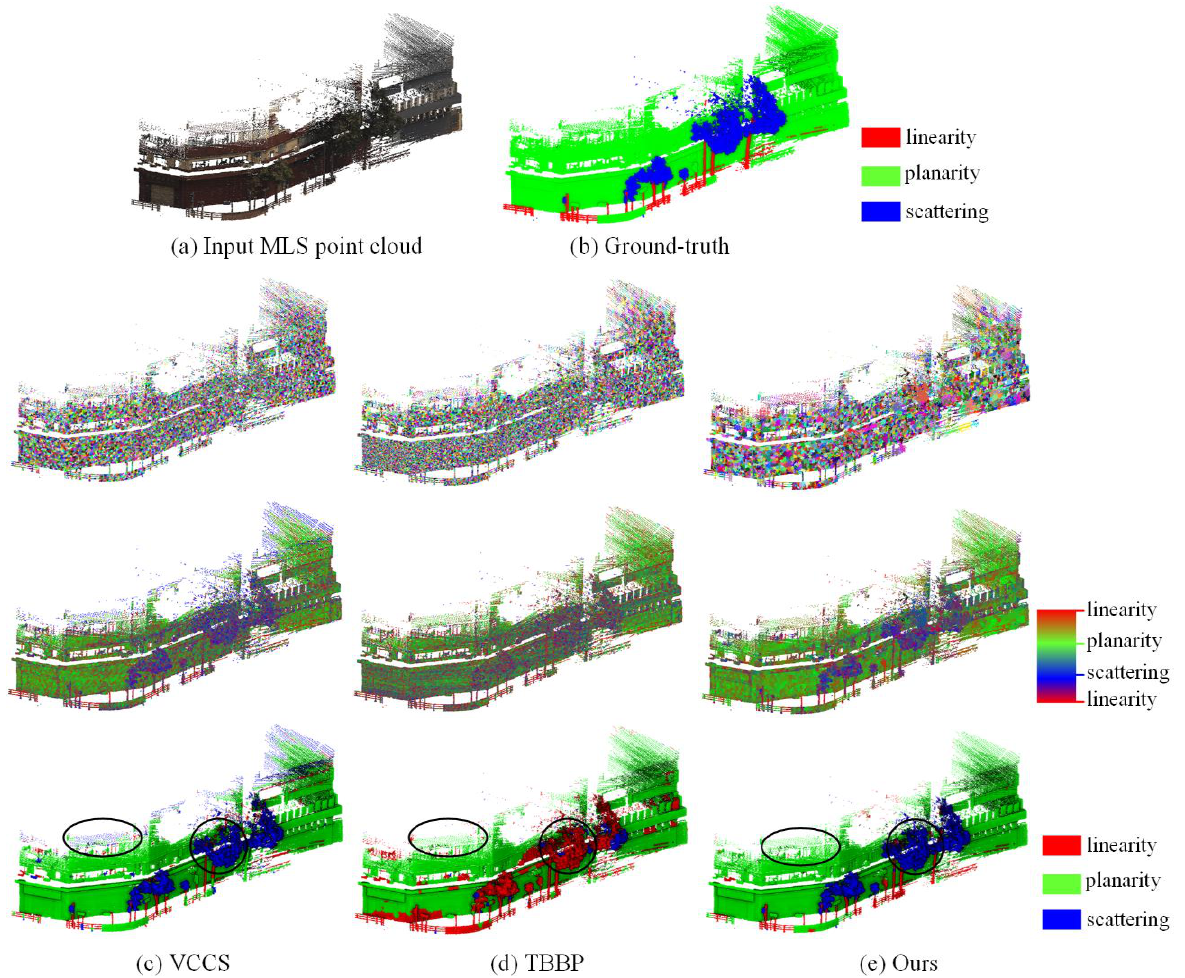
Figure 5. Comparison of structural segmentation results of the MLS dataset. (a) is the input MLS point cloud, (b) is the manually labeled ground-truth with red, green and blue referring to linearity, planarity and scattering, respectively. (c) – (e) show the segmentation results derived supervoxels generated by VCCS, TBBP and our method. In (c) – (e), from top to bottom are the random colour-coded supervoxels, visualized shape descriptors derived from supervoxels and the structural components colour-coded based on their